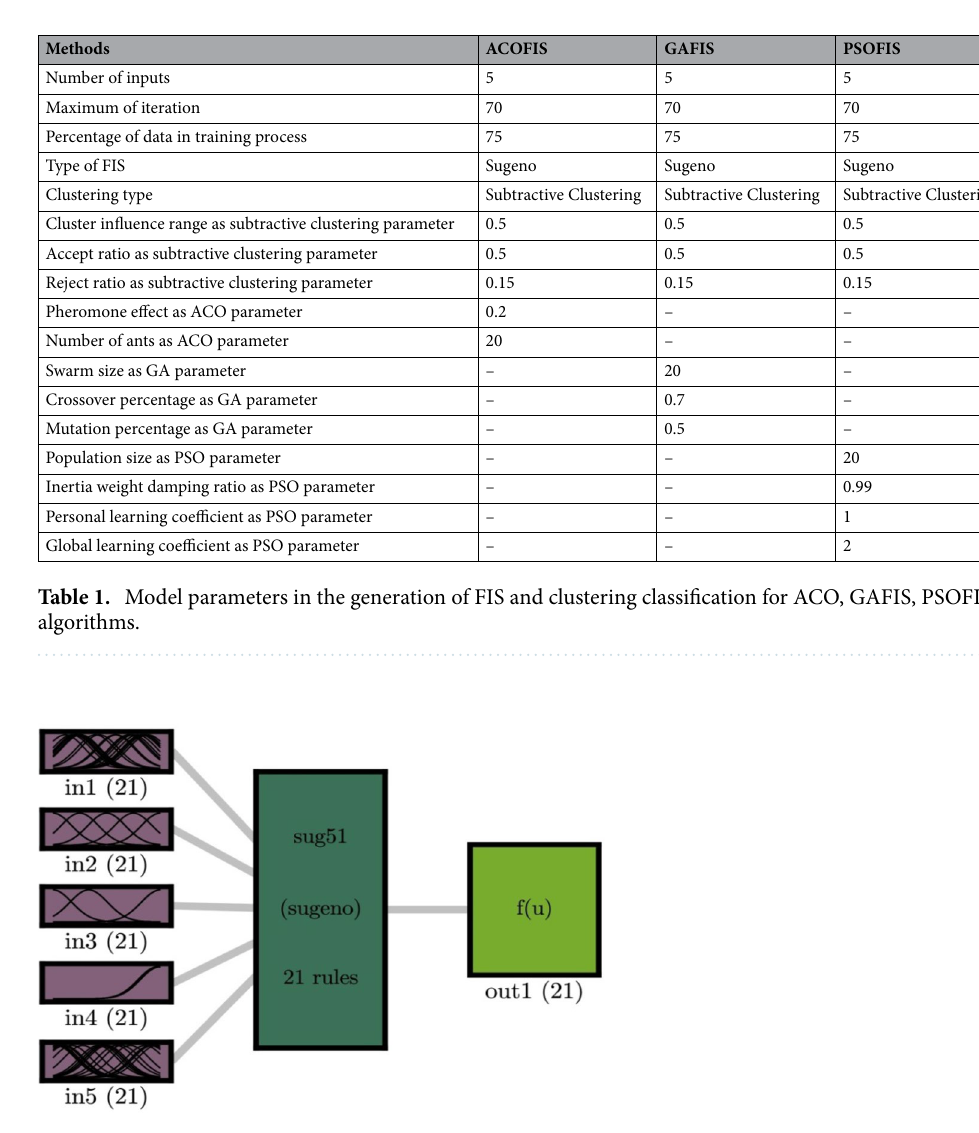
Figure 1. FIS system based on ACO algorithm in the learning process, using subtractive clustering in the best of ACOFIS intelligence when CIR is 0.5, number of ants is 20, and the pheromone effect is